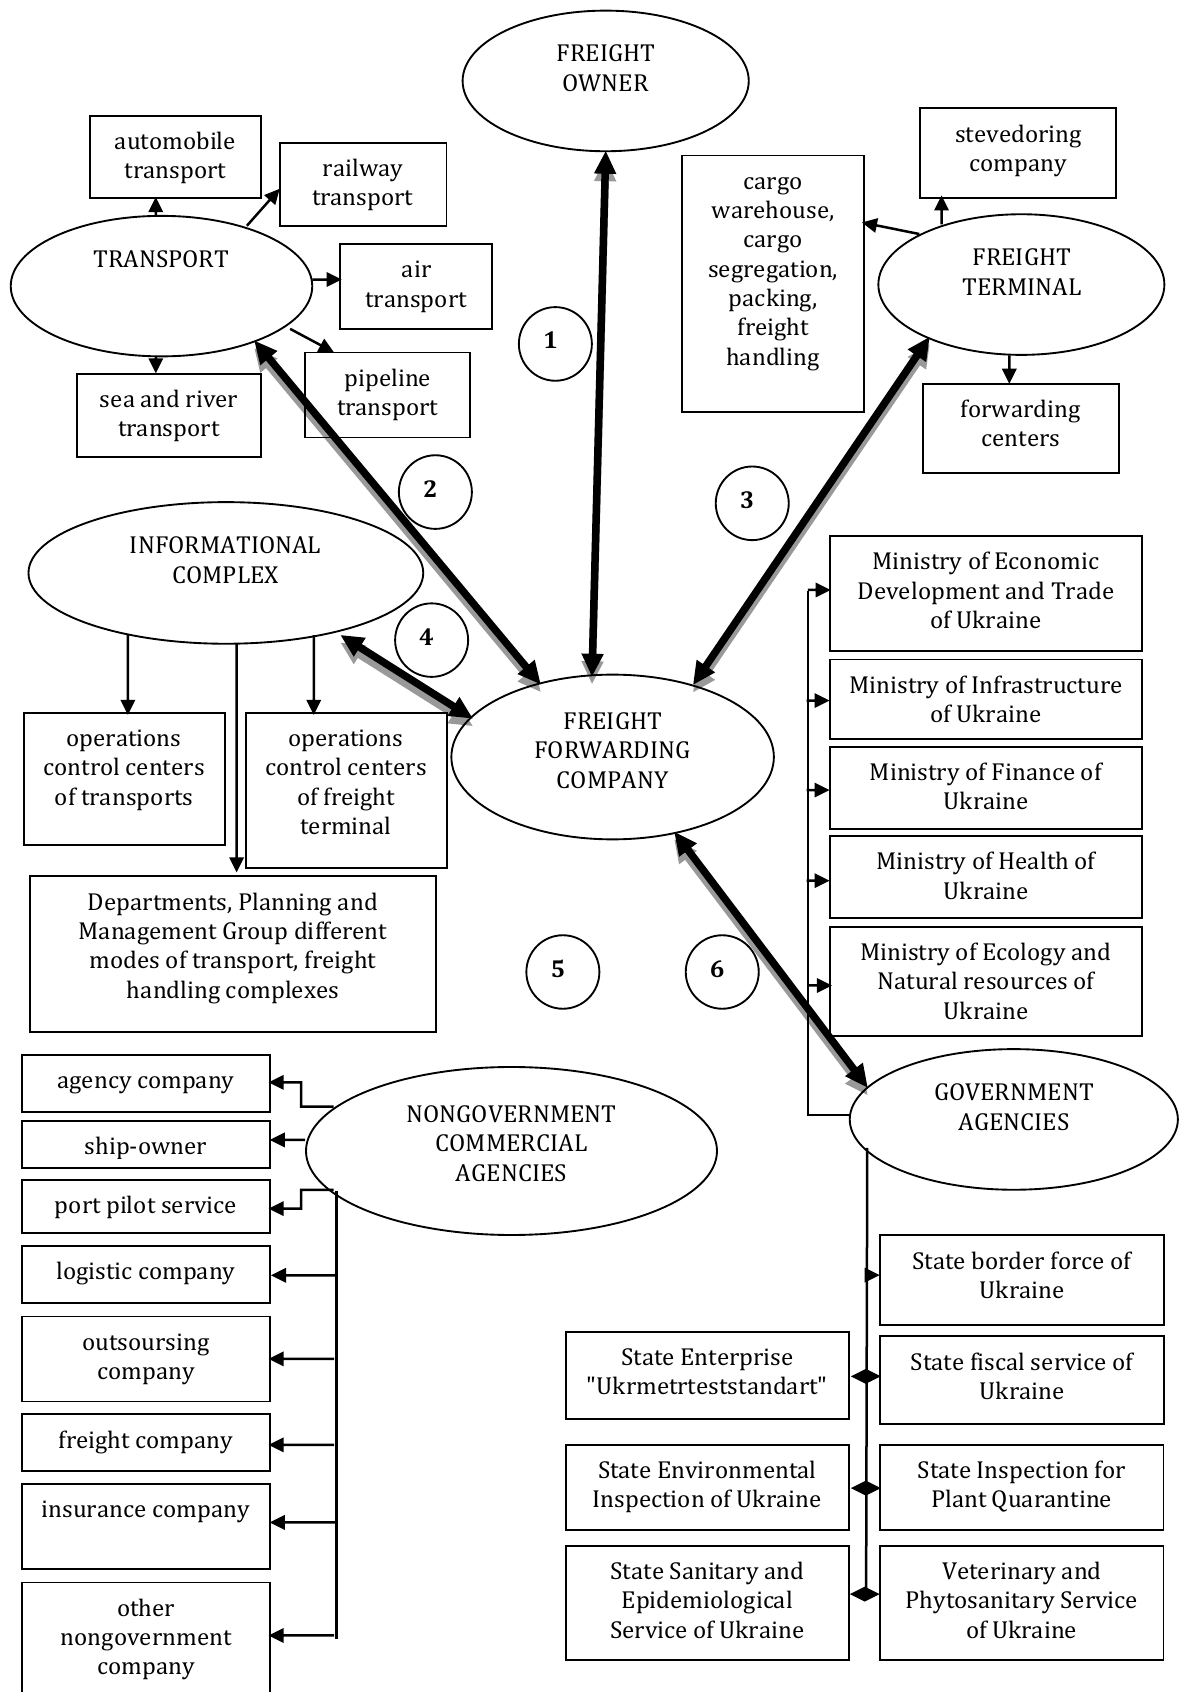
Fig. 1. Principle scheme of the interaction of freight-forwarding companies with elements of freight- forwarding